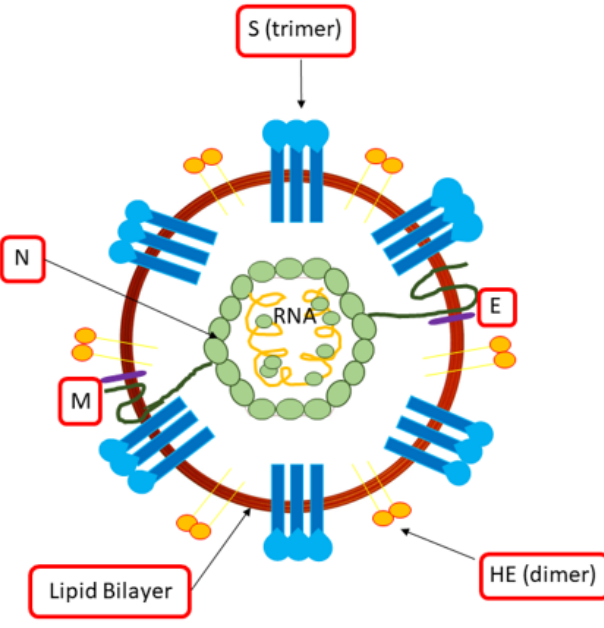
Figure 1. Morphological organization of the coronavirus.